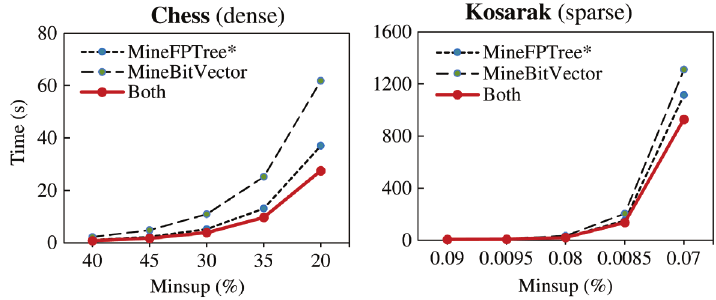
Figure 13. Execution Time of Using Single Mining Strategy vs. Using